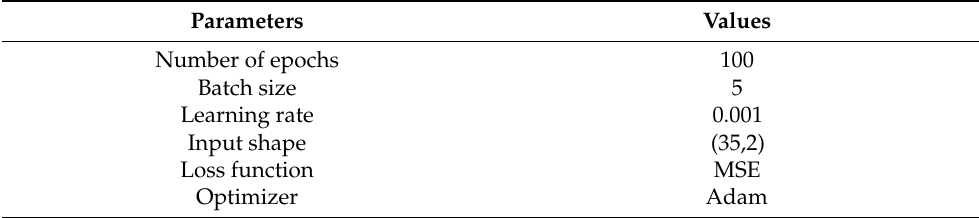
Table 7. Training parameters of the car trajectory prediction model.